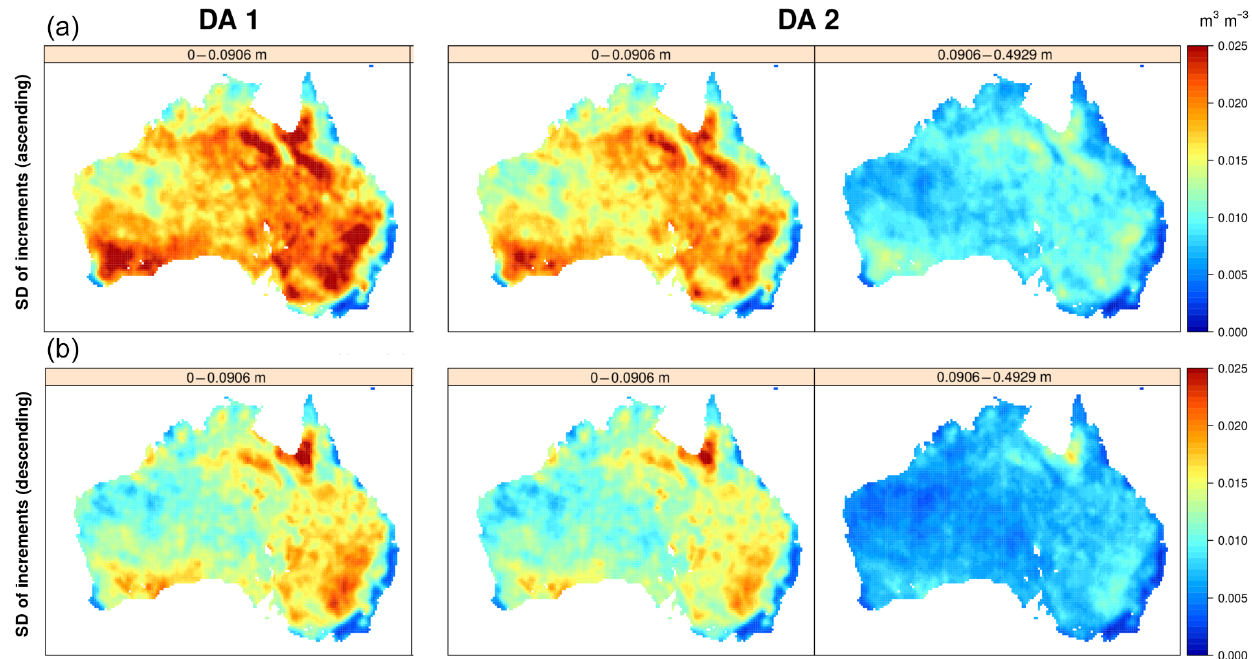
Figure 7. Standard deviation of increments for experiments DA 1 and DA 2 for top-layer soil moisture and root-zone soil moisture for ascending (a) and descending orbits (b) . Increments are strongest for the ascending orbit and for top-layer soil moisture and even stronger when restricting assimilation to these layers, as in DA 1. Increments are very low or zero for the forested areas along the coastline, either due to the absence of observations or the high LAI values masking any soil moisture signal within the forward